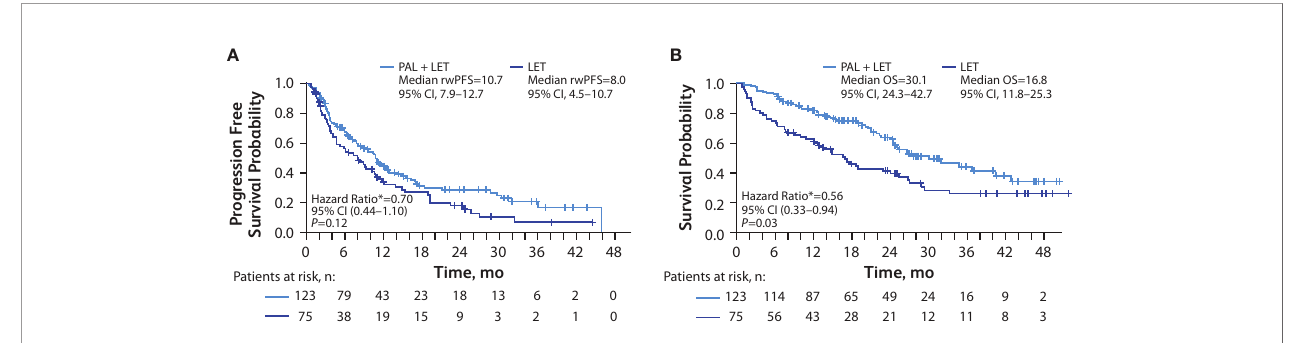
FIGURE 4 | Kaplan-Meier curves of real-world progression-free survival and overall survival in patients with liver metastasis. Analysis of rwPFS (A) and OS (B) adjusted for demographic and clinical variables; number of patients at risk are shown. LET, letrozole; OS, overall survival; PAL, palbociclib; rwPFS, real-world progression-free survival. *Hazard ratios were estimated by multivariate Cox regression models adjusted for baseline demographic and clinical variables.